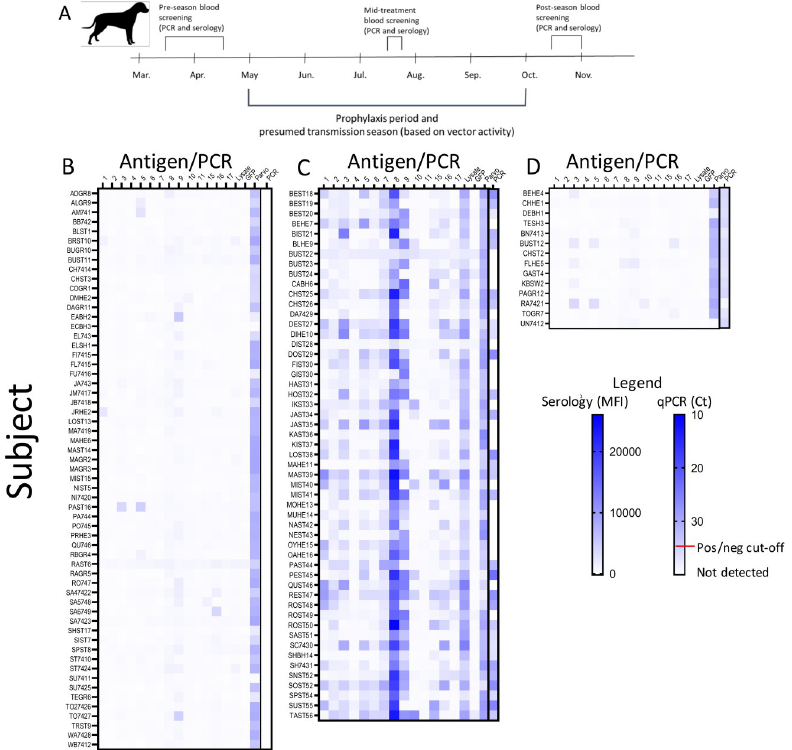
Fig 2. Initial screening results with multiplex serology and PCR to identify T . cruzi -negative dogs to enroll in the prophylaxis study. (A) Schematic representation of dog screening and prophylaxis trial. Heatmaps of antibody levels (mean fluorescence intensity; MFI) and qPCR measurement of T . cruzi DNA in blood were used to classify dogs as uninfected (B) , T . cruzi -infected (C) , or seronegative but with a blood PCR result that did not reach the cut-off for being considered positive (D) . Recombinant T . cruzi proteins are defined in the Materials and Methods; lysate = a sonicate of T . cruzi trypomastigotes and amastigotes; GFP = recombinant green fluorescent protein (negative antigen control); Parvo = Parvovirus vaccine antigen (positive serological